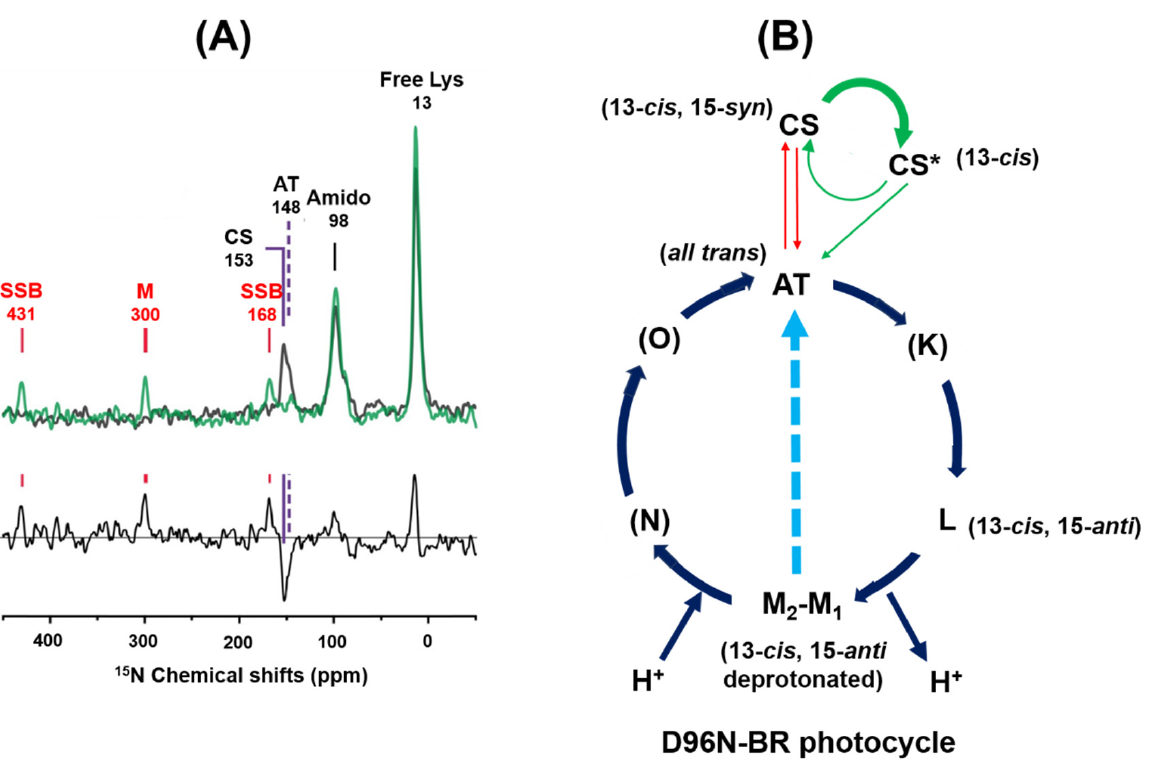
Figure 8. ( A ) 15 N CP-MAS NMR spectra of [ ε - 15 N]Lys-D96N-BR were recorded at − 60 °C in the dark (black line) and under green light illumination (green line), and the difference in spectra between the black line and green lines was obtained as shown in the bottom line. The difference spectrum of [ ε - 15 N]Lys 216 -D96N-BR indicated that the AT state changed to the M intermediate. ( B ) Photoreaction cycle of D96N-BR. In the AT photocycle, the L and M intermediates were detected, and the M intermediate directly changed to the AT state. In the CS photocycle, the CS state was changed to the CS* intermediate and then to the AT intermediate. (K), (N) and (O) intermediates were not detected using in situ photoirradiation solid-state NMR.